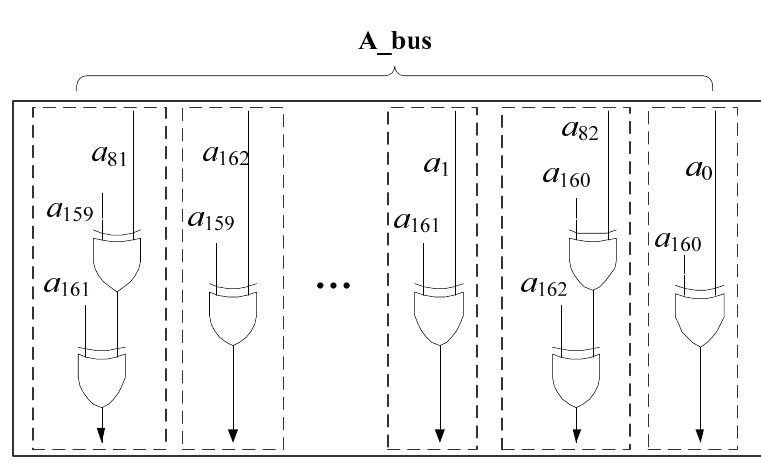
Figure 4. Squaring Circuit in GF (2 163